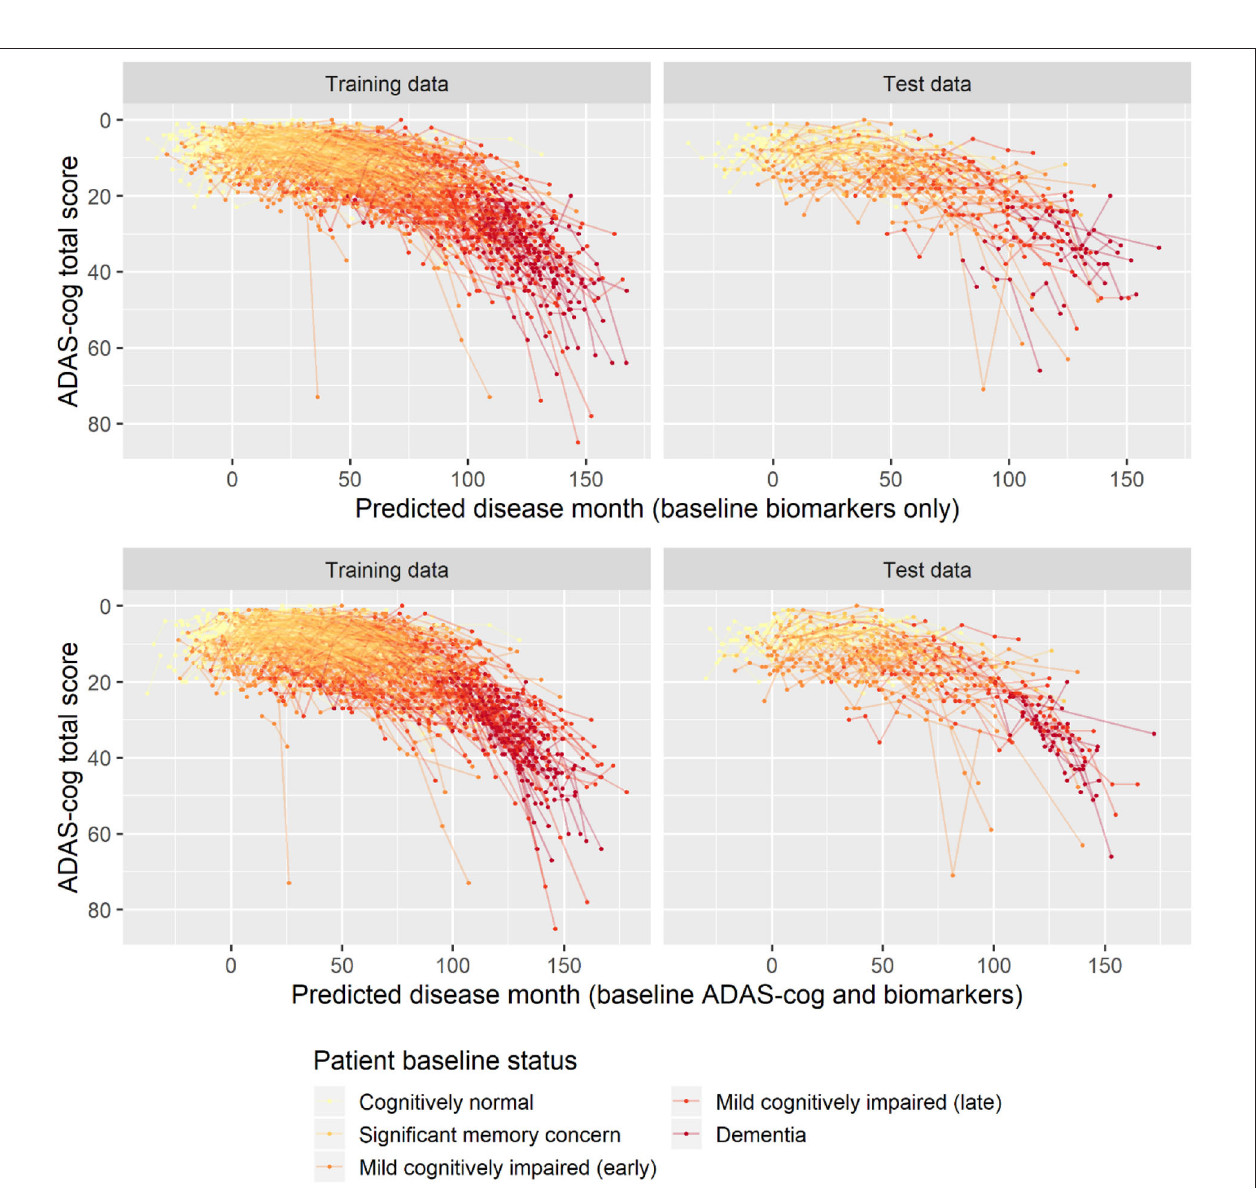
FIGURE 9 | Predicted disease month for training and test datasets. Top row displays predicted disease-time alignment of observed ADAS-Cog total score trajectories based on baseline biomarker data and patient baseline status; bottom row displays predicted disease-time alignment of trajectories based on baseline ADAS-Cog total score, baseline biomarker data, and patient baseline